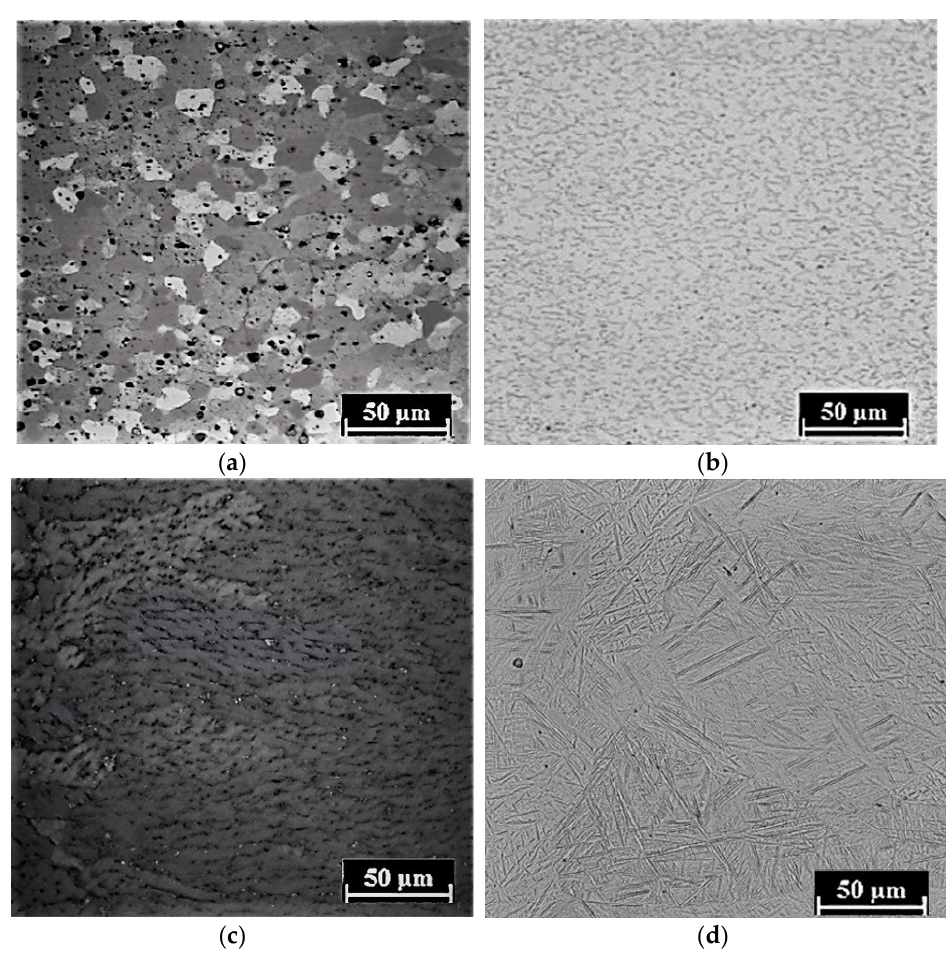
Figure 2. Optical micrographs of the AA6061 BM ( a ), Ti-6Al-4V BM ( b ), AA6061 FZ ( c ) and Ti-6Al-4V FZ ( d ).